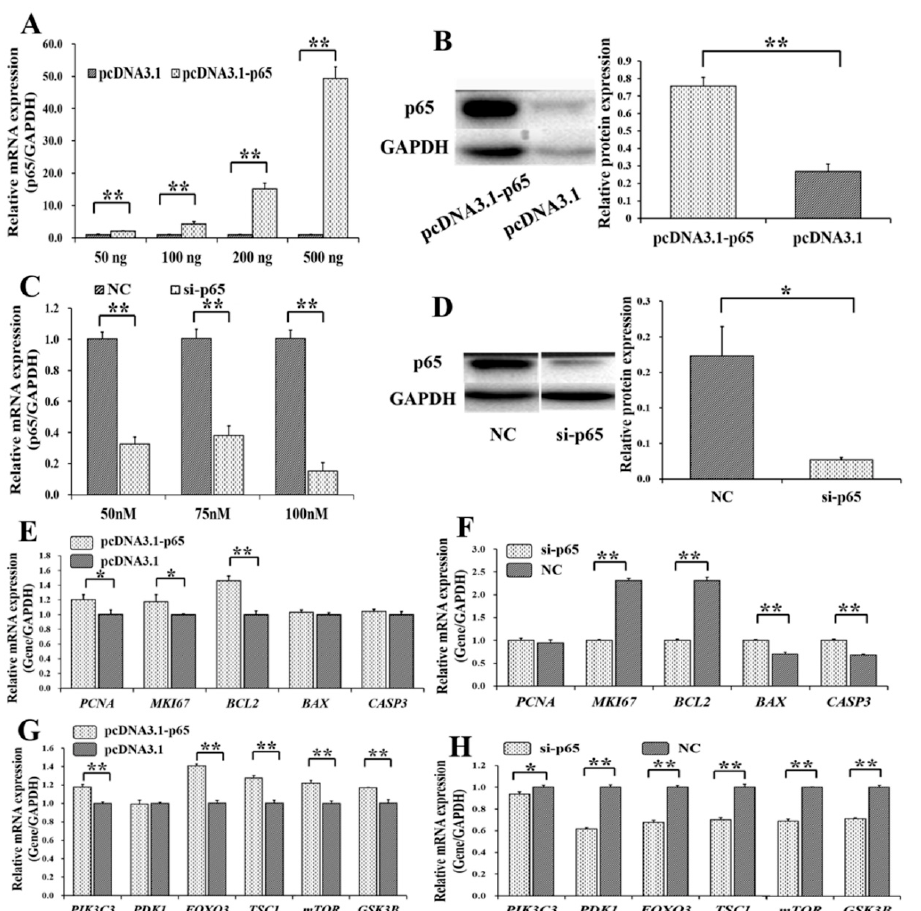
Figure 2. Biological effects of p65 on apoptosis and PI3K signaling pathway. ( A ) The mRNA level of p65 under different concentrations of pcDNA3.1-p65 plasmid; ( B ) the protein count of p65 was